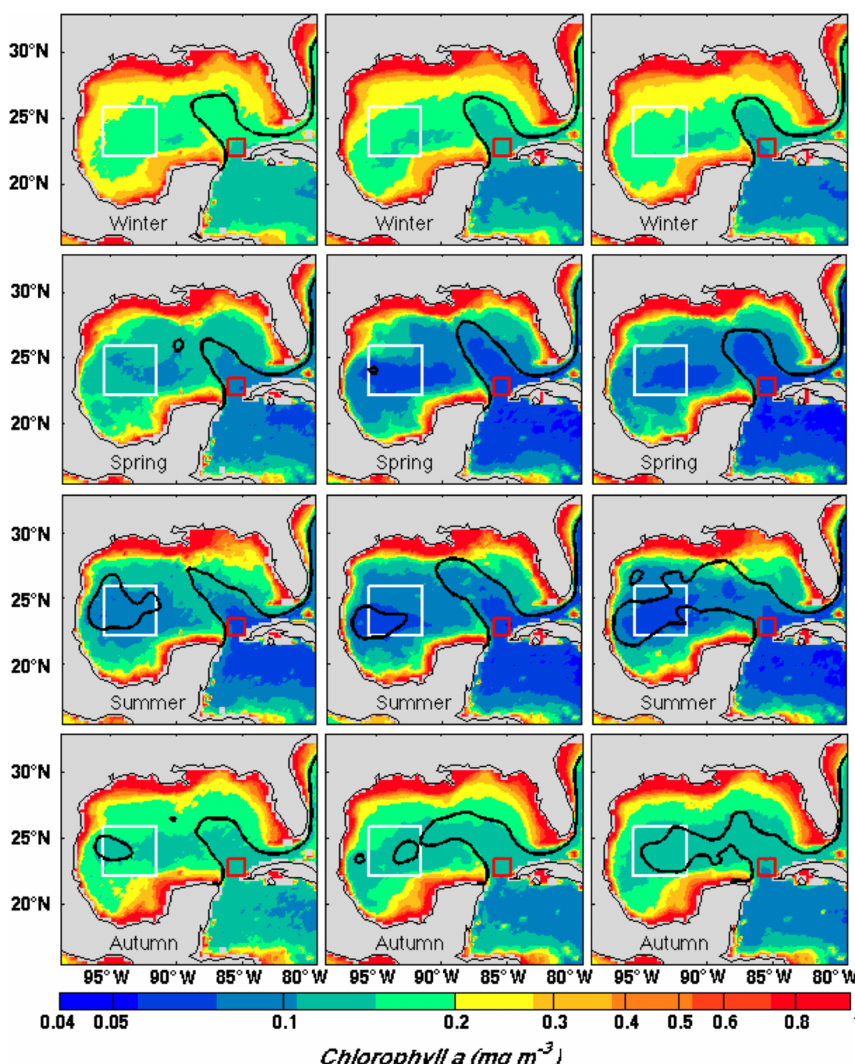
Figure 9. From top left to bottom right, average Chl a values according to period: column 1 is SeaWIFS 1998–2002, column 2 is MODIS 2003–2008, and column 3 is MODIS 2009–2014. From top to bottom the panels correspond to the mean seasons. The average Chl a concentration is computed inside the white and red squares (white corresponds to the western GoM and red corresponds to the LC area). Average values for each time period and season are in Table